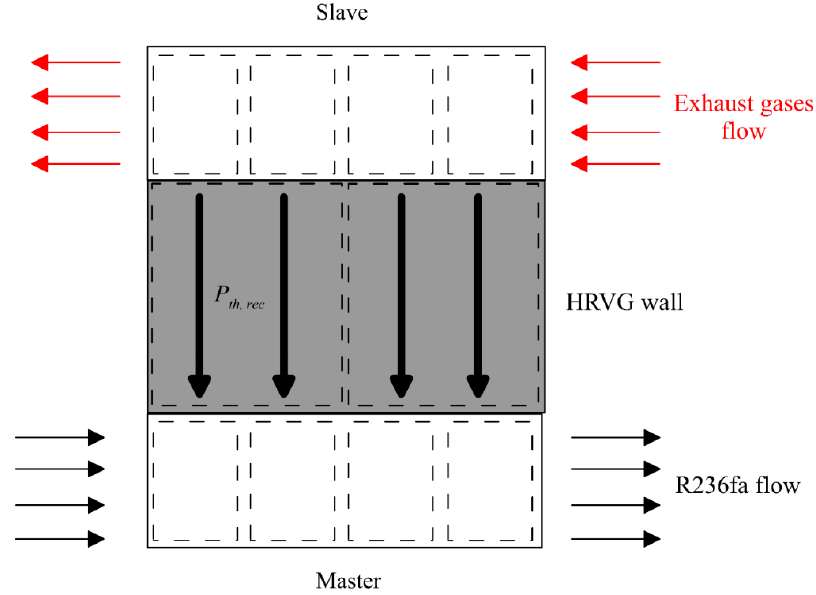
Figure 6. Modeling approach for the HRVG based on the master and slave parameterization.